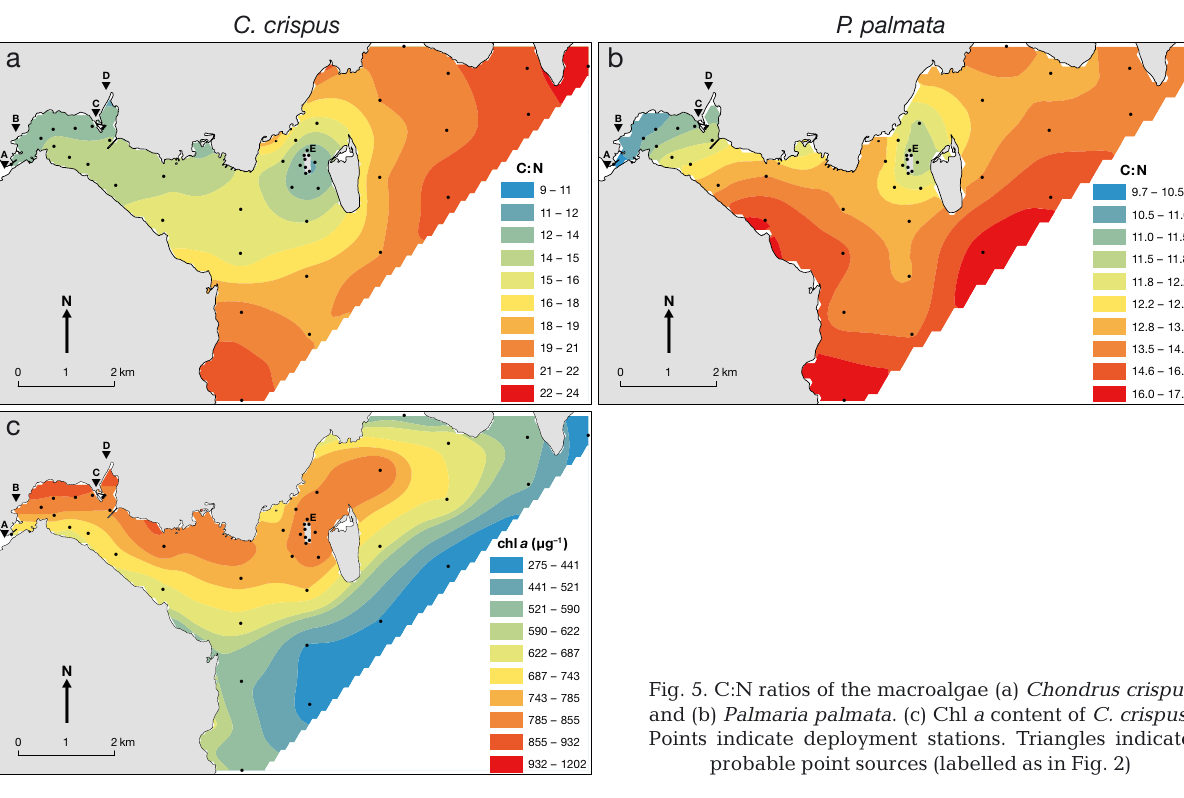
Fig. 5. C:N ratios of the macroalgae (a) Chondrus crispus and (b) Palmaria palmata . (c) Chl a content of C. crispus . Points indicate deployment stations. Triangles indicate probable point sources (labelled as in Fig.